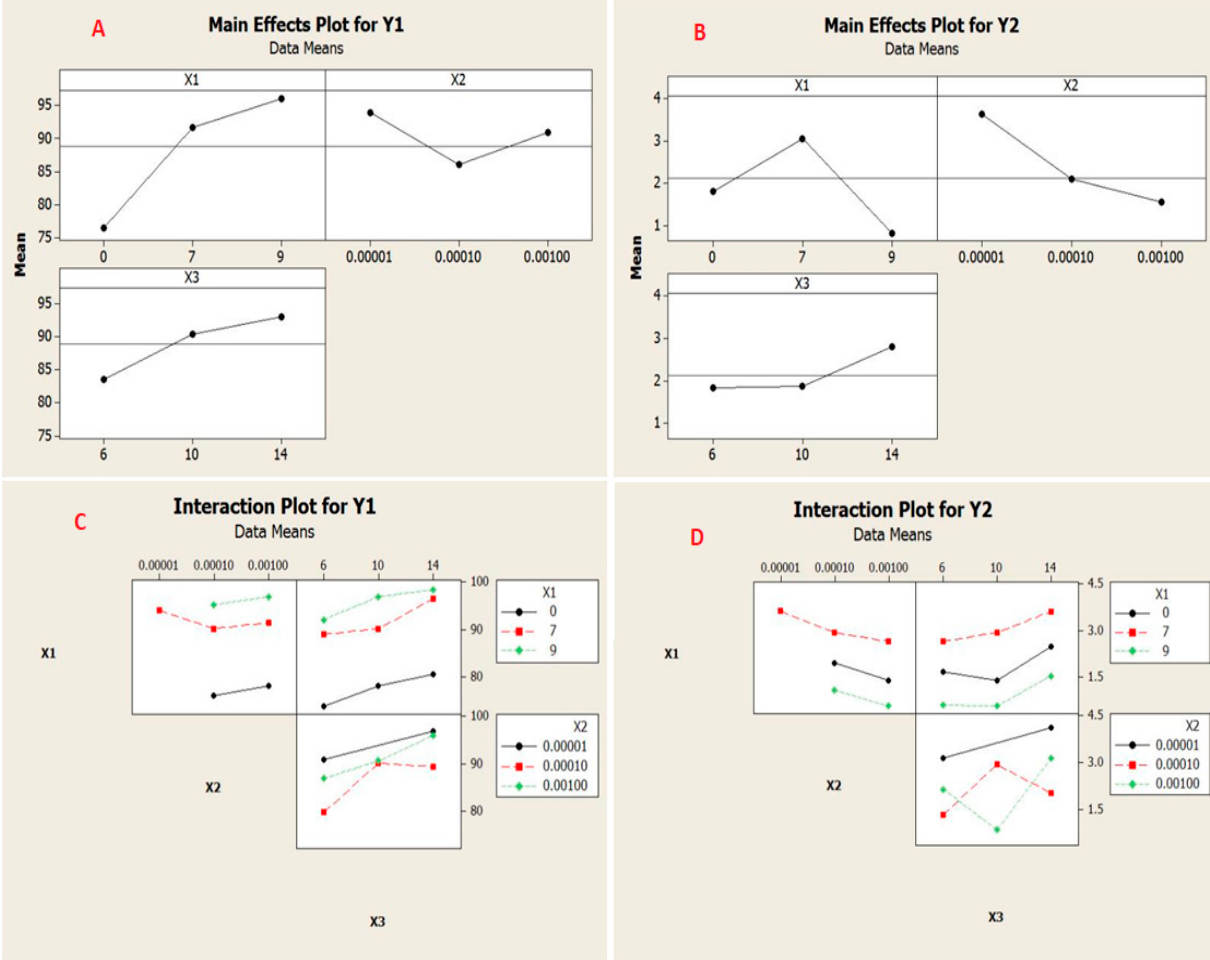
Figure 12. Major impact plot for rejection ( A ) and membranes permeate flux ( B ), and interaction plots for rejection ( C ) and permeate flux ( D ).